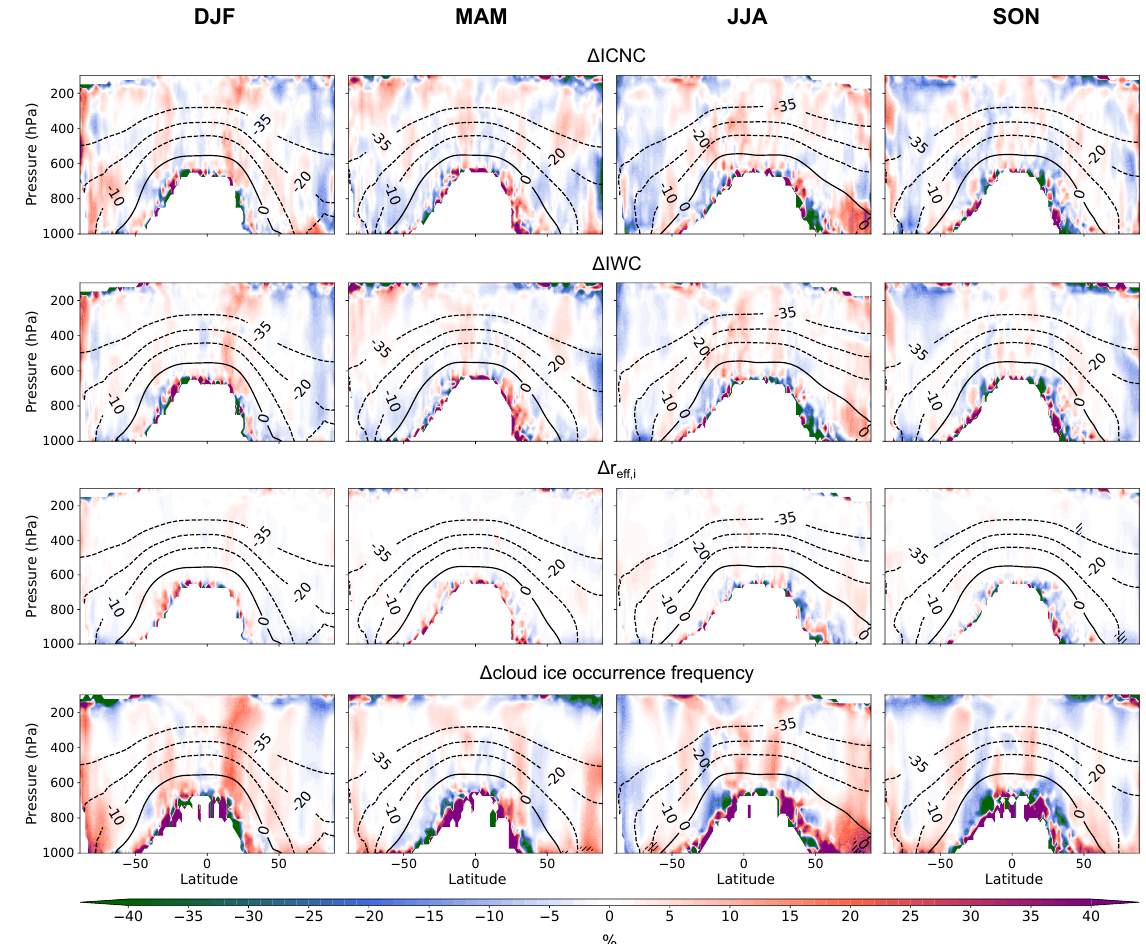
Figure 10. Same as in Fig. 9 but for seasonal mean changes in the cloud ice properties only.